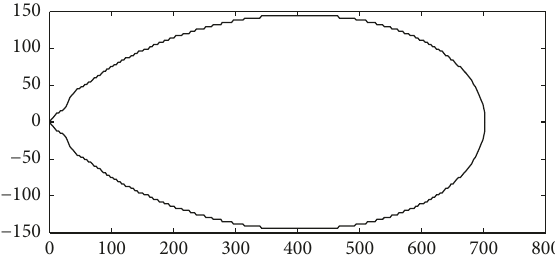
Figure 2: The influenced area of liquid chlorine leakage.